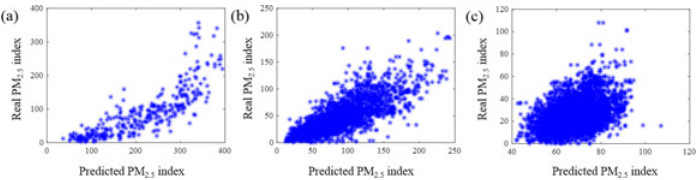
Fig 9. Real PM 2.5 index vs. predicted PM 2.5 index plot. (a) Beijing; (b) Shanghai; (c)